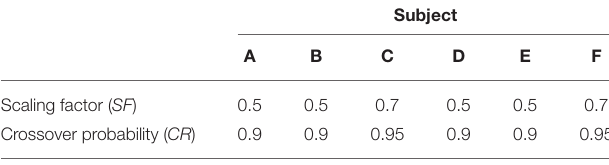
TABLE 2 | Settings for differential